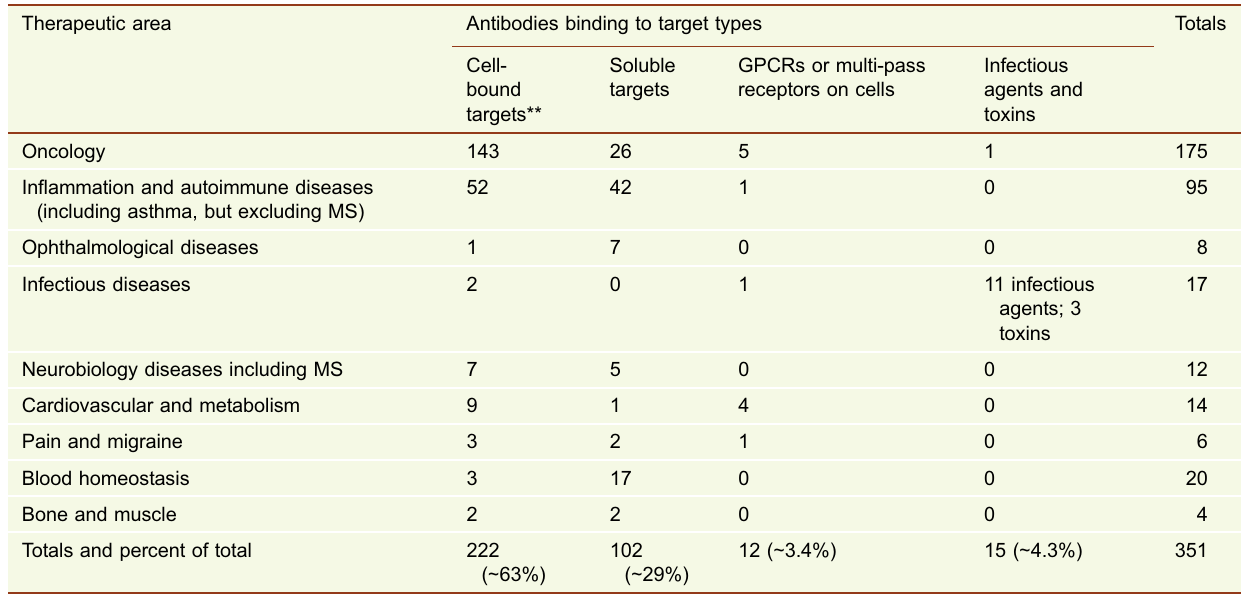
Table 5. Distribution of targets for antibodies and Fc fusion proteins by major indications in therapeutic areas and location* Therapeutic